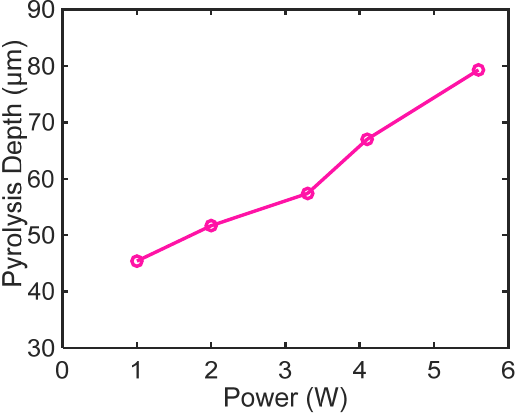
Figure 5. Variation in pyrolysis depth as a function of laser power (laser beam diameter: 125 µm).